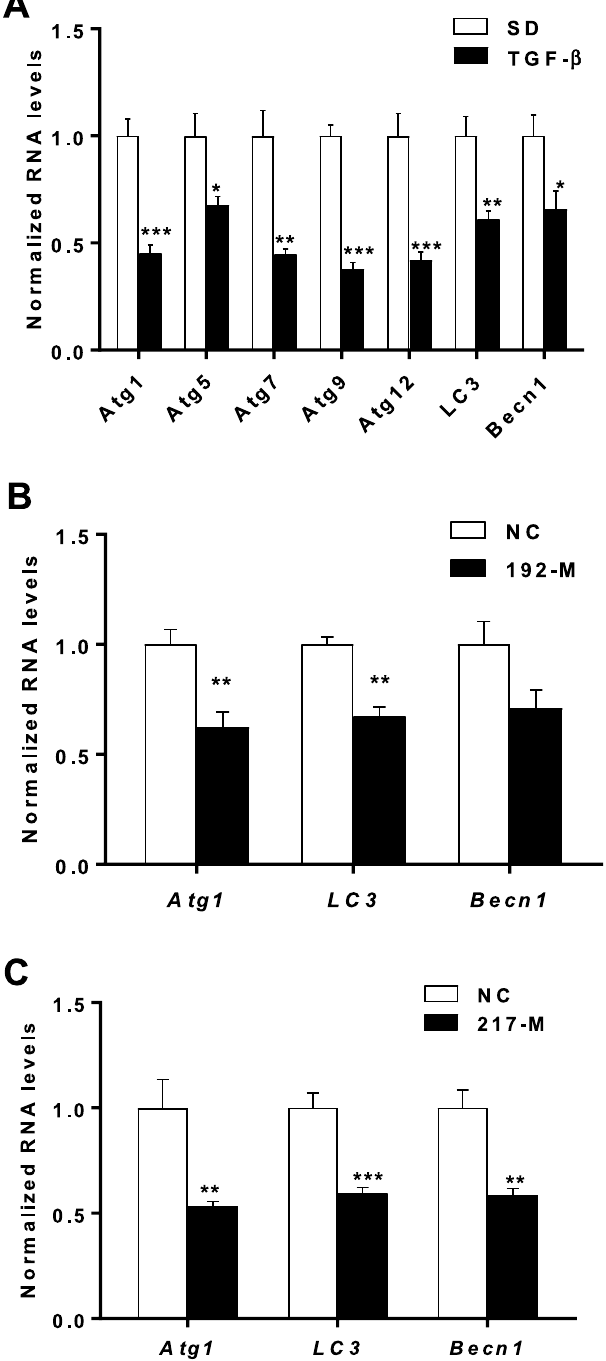
Figure 5. Autophagy gene expression in MMCs treated with TGF- β or with miR-192-M and miR-217M.qRT- PCR analysis of autophagy genes in ( A ) WT-MMCs treated with TGF- β (n = 3) ( B ) WT-MMCs transfected with either negative control (NC) or miR-192 mimic oligonucleotides (192-M) (n = 3). ( C ) WT-MMC transfected with either negative control (NC) or miR-217 mimic oligonucleotides (217-M) (n = 3). Error bars SEM * P < 0.05; ** P < 0.01; *** P <